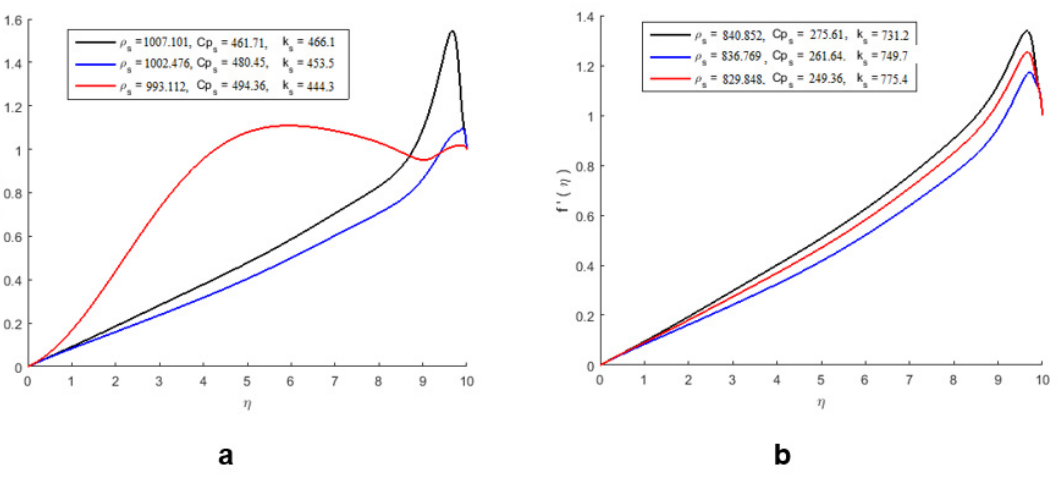
Figure 7. The effect of pure nanoparticle parameters on the velocity profile of pure nanoparticles and mixed nanoparticles. ( a ) Velocity profile of pure nanoparticles. ( b ) Velocity profile of nanoparticles mixed with water.